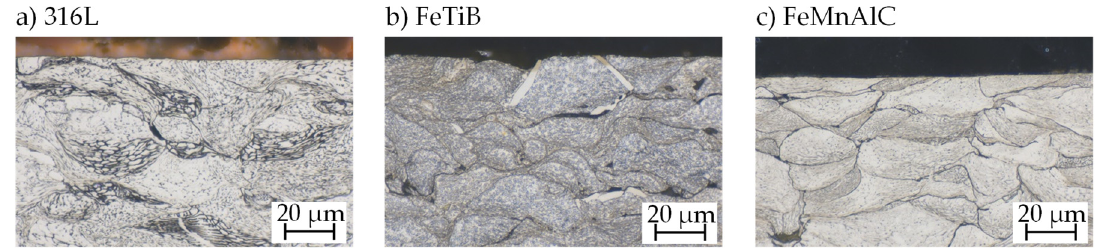
Figure 7. Microstructure after milling: ( a ) etched 20 s in 60% electrolytic HNO 3 (1.5 V); ( b , c ) etched 15-20 s in 3% alcoholic HNO 3.